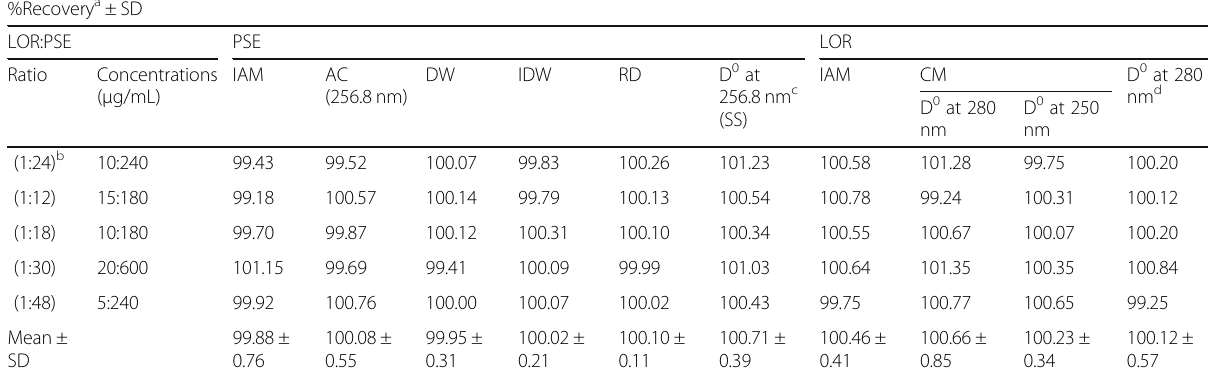
Table 2 Determination of PSE and LOR in the laboratory-prepared mixtures by the proposed spectrophotometric methods %Recovery a ± SD